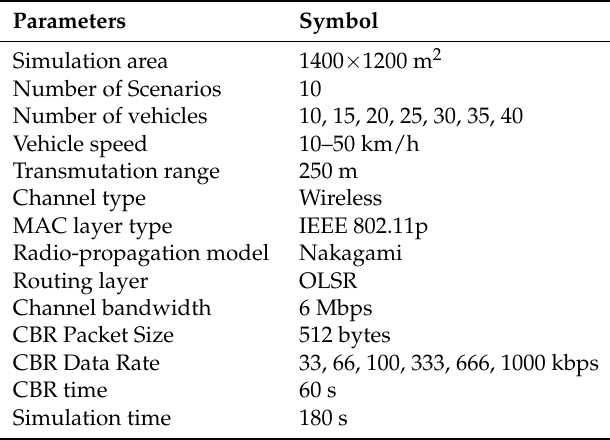
Table 3. Simulation Parameters